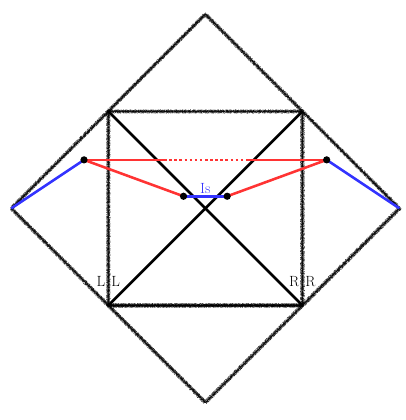
Figure 10 . We draw the Penrose diagram of the full 2d spacetime. One two-sided AdS 2 black hole spacetime is joined to the R/L (cid:13)at regions of (cid:27) + R/L point has coordinates ( t extremization, the lower R/L point has coordinates ( t; after extremization. The blue line denoted by \Is" is for the island